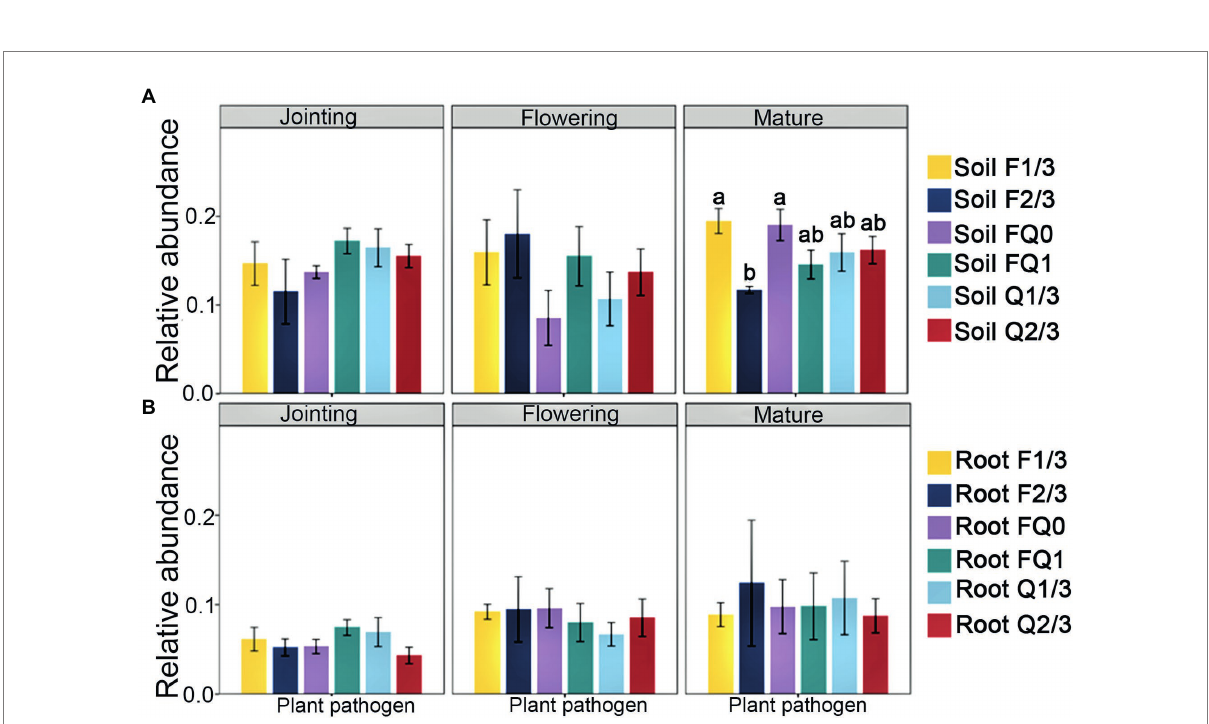
FIGURE 3 The relative abundance of plant pathogens in (A) rhizosphere soil and (B) roots. Different letters indicate significant differences at p < 0.05. No letter indicates significant differences at p > 0.05 between all groups. Treatments are defined in Figure 2